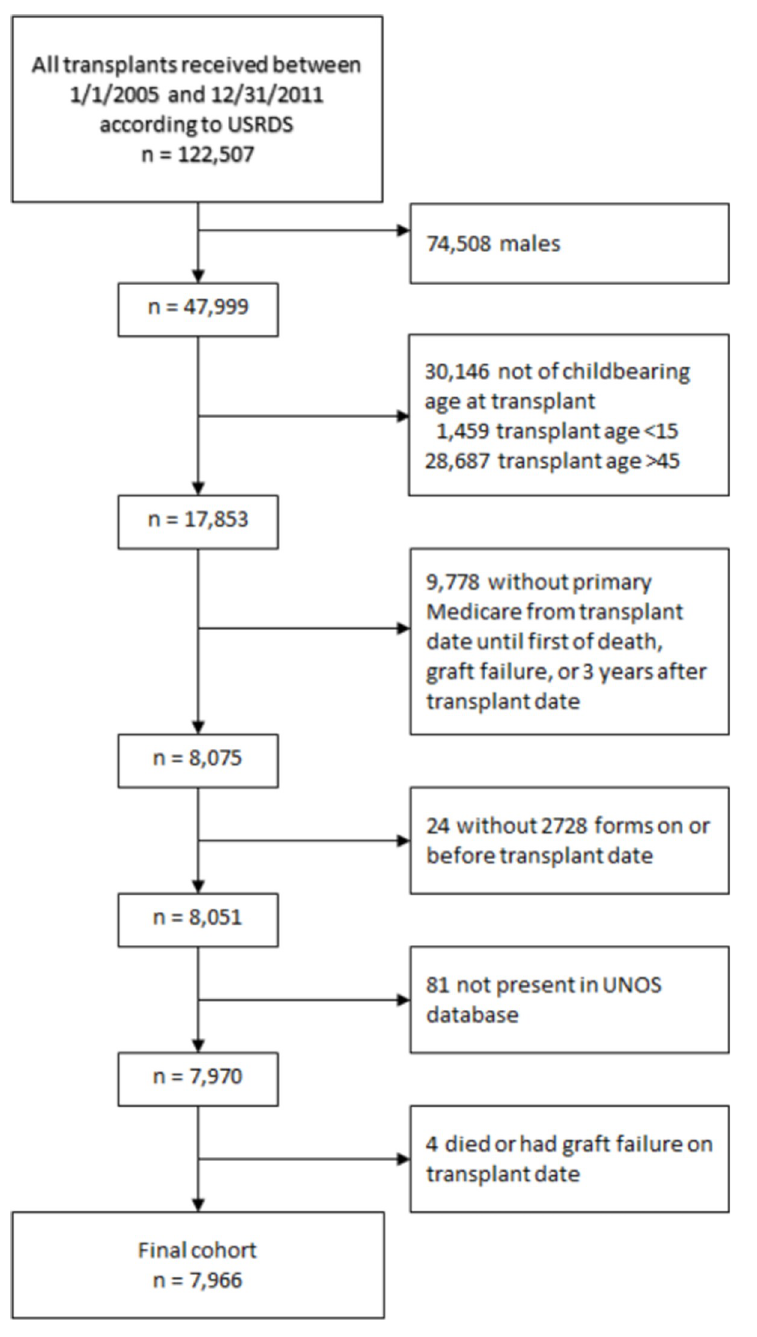
Fig 1. Cohort selection flow